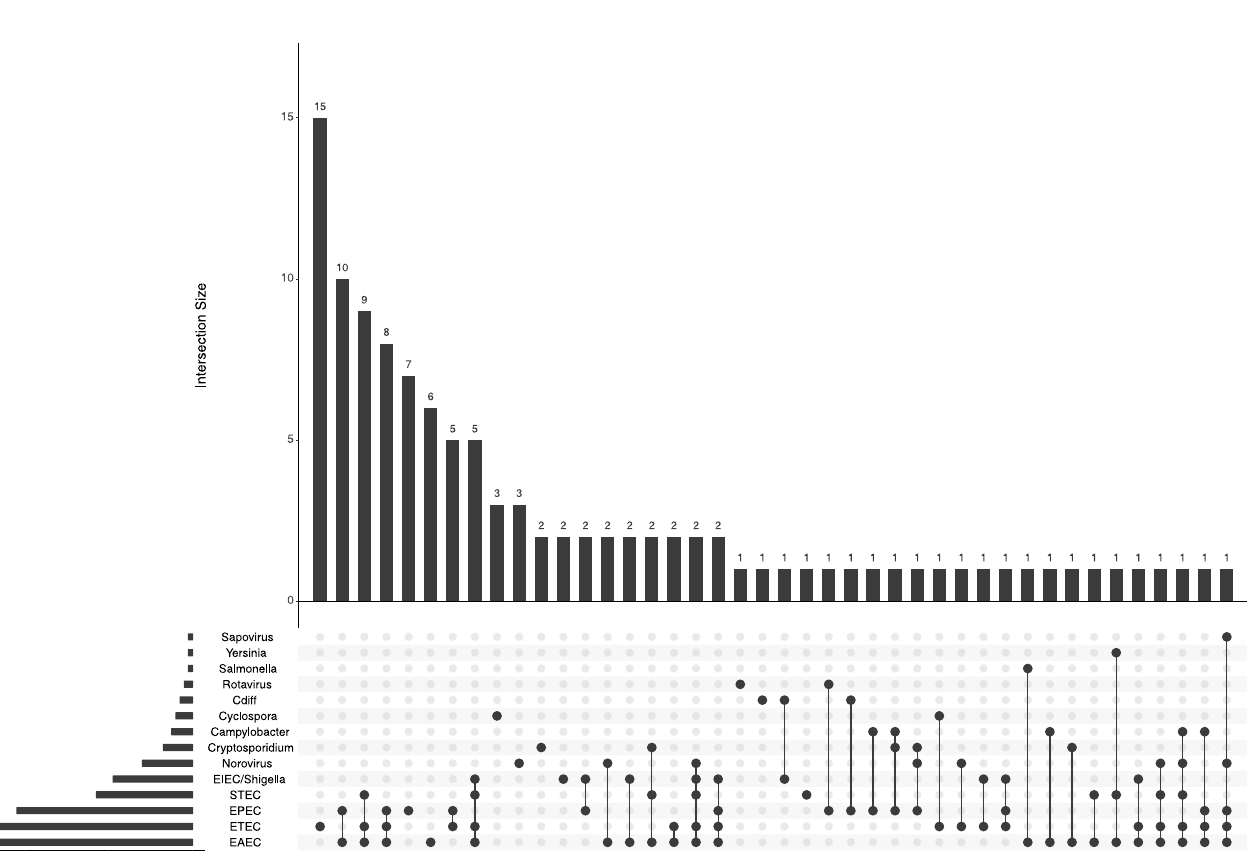
Fig 1. Intersections of pathogen infections across the study 1 and 2 cohorts. Pathogens are shown on the lower left, with the size of the horizontal bars indicating the frequency of the pathogen incidents across the data set. The vertical bar charts indicate the sorted counts of each set interaction, with the bottom dots and connecting lines indicating detection of a pathogen and its co-occurrence with other pathogens, e.g., ETEC occurred alone 15 times, EPEC and EAEC were a co-infection 10 times, and so on. Co-infections were quite prevalent, with rare cases of predominantly singly-infectious agents, such as Cyclospora (detected three times alone, once as a co- infection with ETEC).